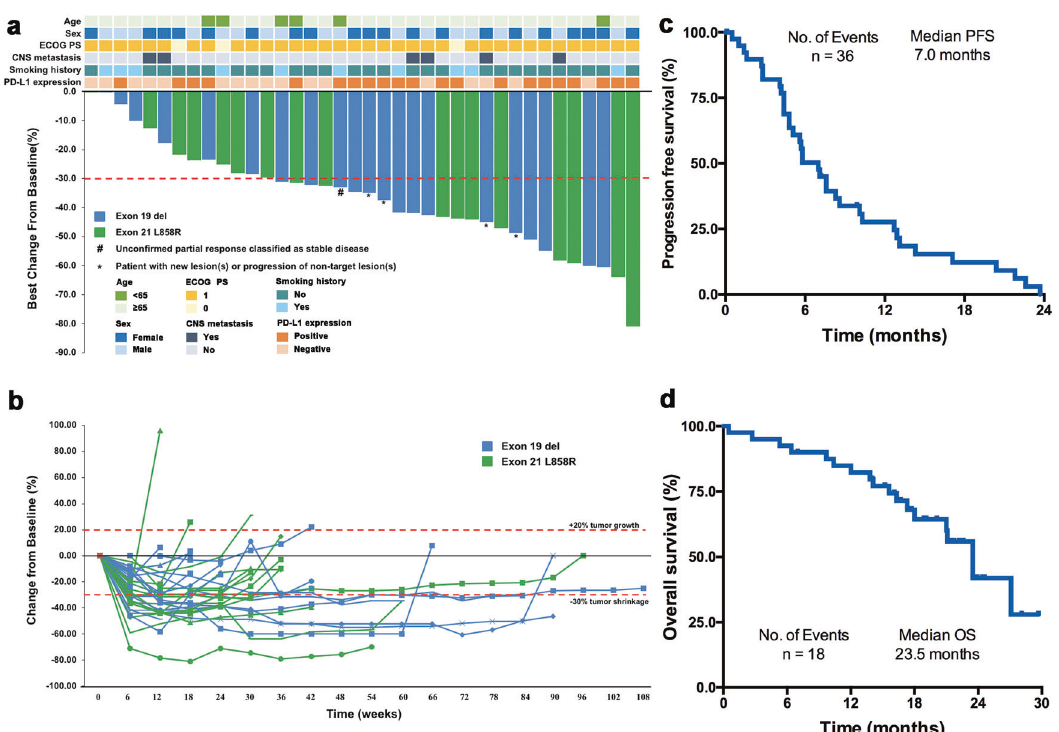
Fig. 2 Summary of treatment response, progression-free and overall survival. a Maximal change of tumor size from baseline assessed by the investigator per RECIST v1.1 ( n = 38). The length of the bar represents maximal decrease or minimal increase in target lesion(s). # Uncon fi rmed partial response classi fi ed as stable disease. * Patient with target lesion(s) reduction over 30% but with new lesion(s) or progression of nontarget lesion(s). b Change of individual tumor burden over time from baseline assessed by the investigator per RECIST v1.1 ( n = 38). c Progression-free survival by RECIST v1.1 of all 40 enrolled patients. d Overall survival by RECIST v1.1 of all 40 enrolled patients. No.